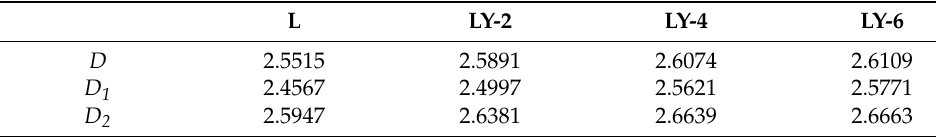
Figure 10. Fractal analysis of N 2 adsorption isotherms: ( a ) L; ( b ) LY-2; ( c ) LY-4; ( d ) LY-6. Table 3. Fractal dimension values for L and LY group